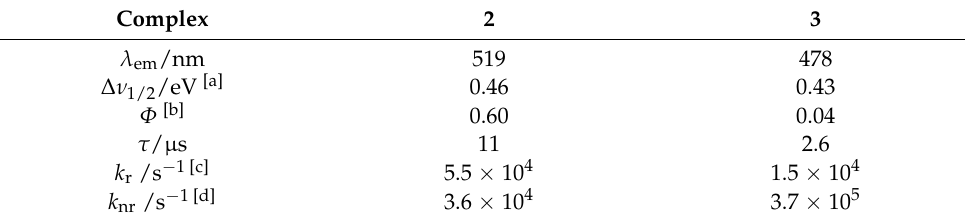
Table 1. Luminescent properties of 2 and 3 in the solid state at room temperature.